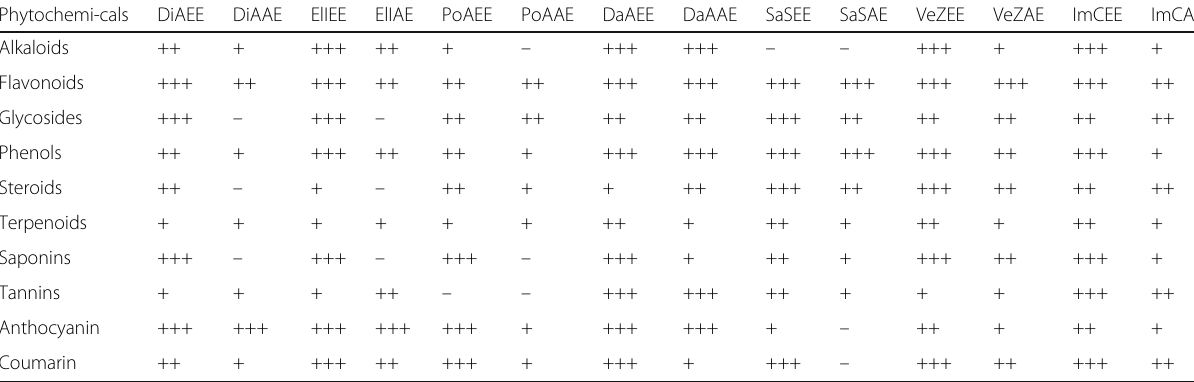
Table 1 Qualitative analysis of phytochemicals of selected plants Phytochemi-cals DiAEE